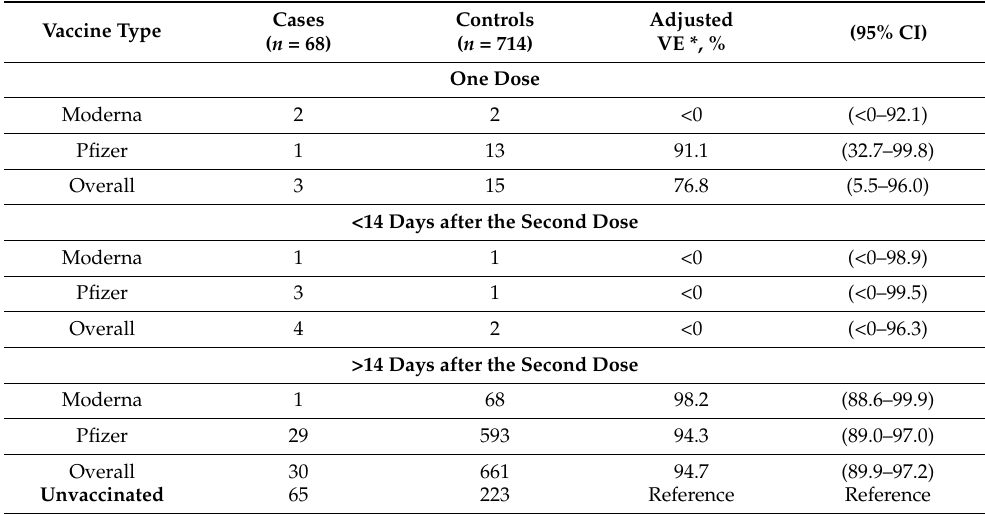
Table 2. Vaccine effectiveness against infection in hemodialysis